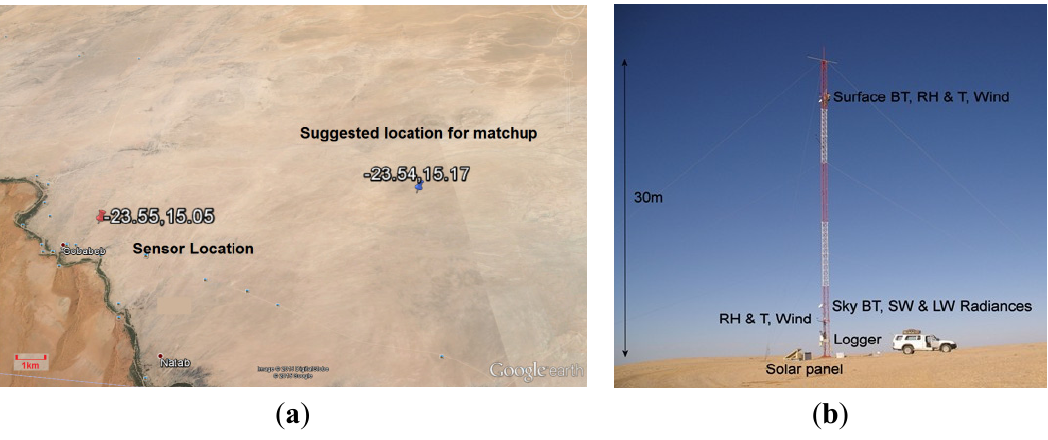
Figure 1. ( a ) is Geographic landscape in Gobabeb station in Namibia and ( b ) is the instrumentation for LST measurement: two radiometers measure the surface-leaving radiance (9.6–11.5 μ m) from the gravel plain, which is highly homogenous over at least 2500 km 2 . A third radiometer measures sky